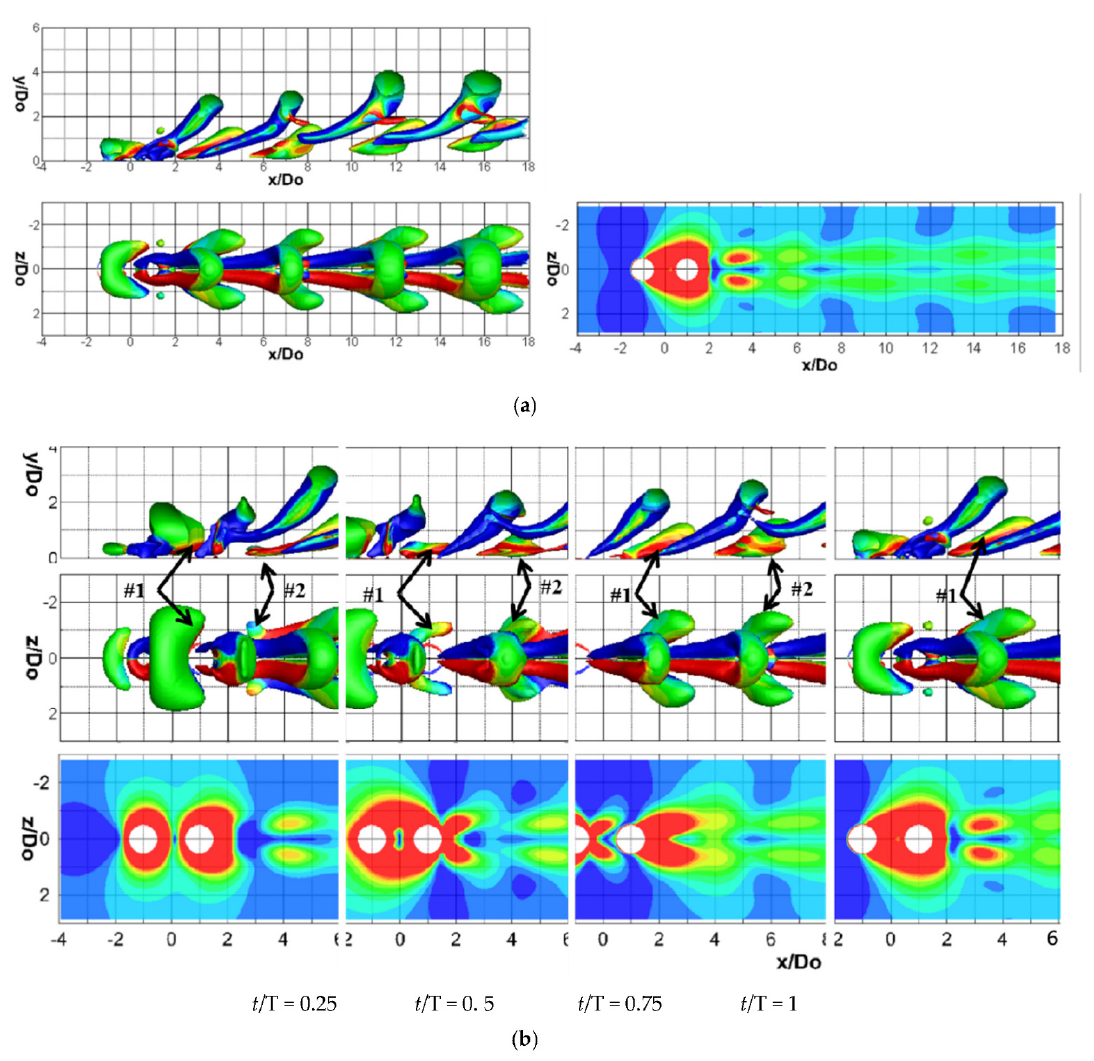
Figure 13. Vortex structures and excess wall shear stress for the twin SJs operating with Δ ϕ = 3 π /2. ( a ) Vortex structures ( left ) and excess wall shear stress ( right ) at t /T = 0. ( b ) Evolution of vortices ( upper two rows) and corresponding excess wall shear stress ( bottom row). The color map can be referred to Figure 11.